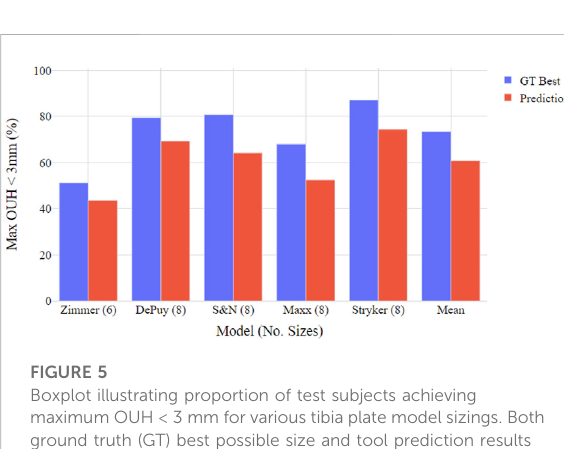
FIGURE 5 Boxplot illustrating proportion of test subjects achieving maximum OUH < 3 mm for various tibia plate model sizings. Both ground truth (GT) best possible size and tool prediction results